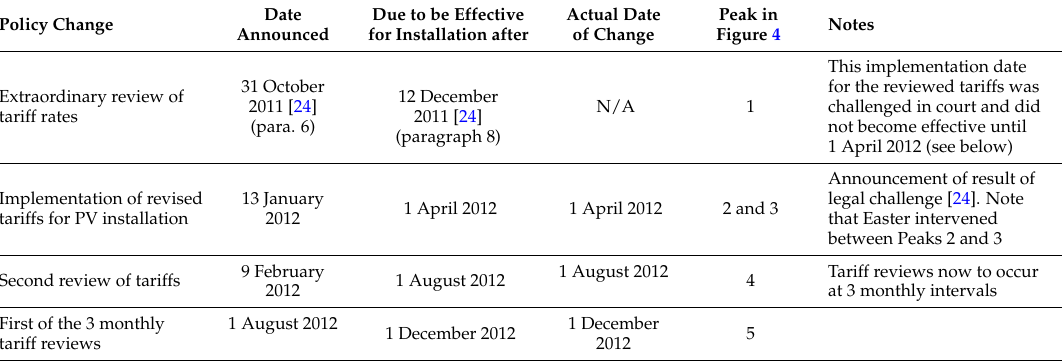
Table 2. Correspondence between policy change, announcement date and PV adoption rate